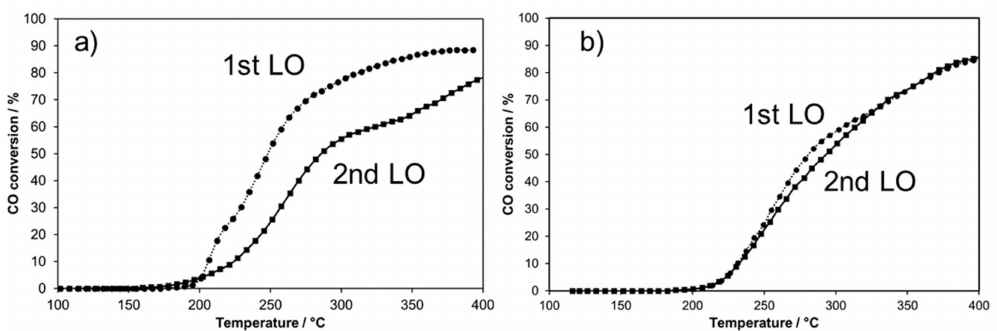
Figure 9. Two successive LO recorded on ( a ) LSACO-4 and ( b ) LSACO-5. Reactive mixture: CO / O 2 = 3000 ppm / 3%. Overall flow = 3.6 L / h.